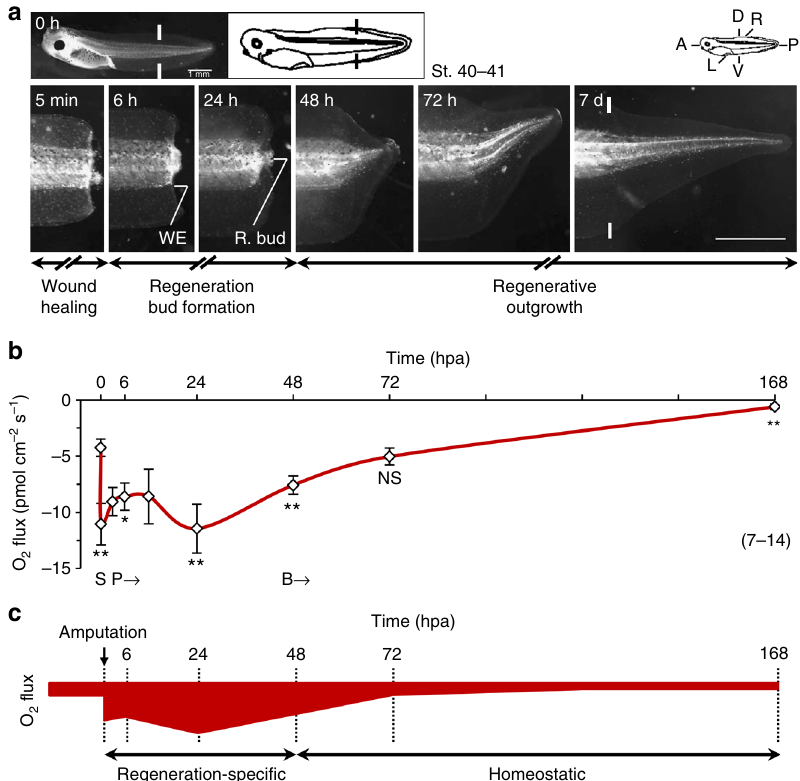
Fig. 1 Extracellular O 2 fl ux dynamically correlates with regeneration. a Regeneration time-lapse and phases of a representative tadpole tail amputated at st. 40 – 41. Major regeneration structures annotated: wound epithelium (WE) and regeneration bud (R. bud). Photomicrographs are displayed in the same orientation as the whole-organism anteroposterior (A/P), dorsoventral (D/V), and left – right (L/R) axes (top left scheme; applies to subsequent fi gures). White solid lines: amputation plane (black solid lines in schematic tadpole); scale bars: 1 mm. b Temporal pro fi le of O 2 fl ux in the regeneration bud in MMR 0.1× (control). Negative values are net in fl ux (applies to subsequent fi gures). Pro fi le is descriptively divided into three parts: S slope; P plateau, and B baseline. c Diagrammatic representation of the temporal dynamic of O 2 in fl ux during regeneration. Pro fi le is divided into two phases: regeneration-speci fi c and homeostatic. Magnitudes are not at absolute scale but present the relative dynamics in temporal directions and magnitudes. Statistical analyses were performed by unpaired Student ’ s t -test (two-tailed p -value). The data are presented as mean ± s.e.m. n biological replicates indicated in brackets. NS non- signi fi cant; * p < 0.05; ** p <